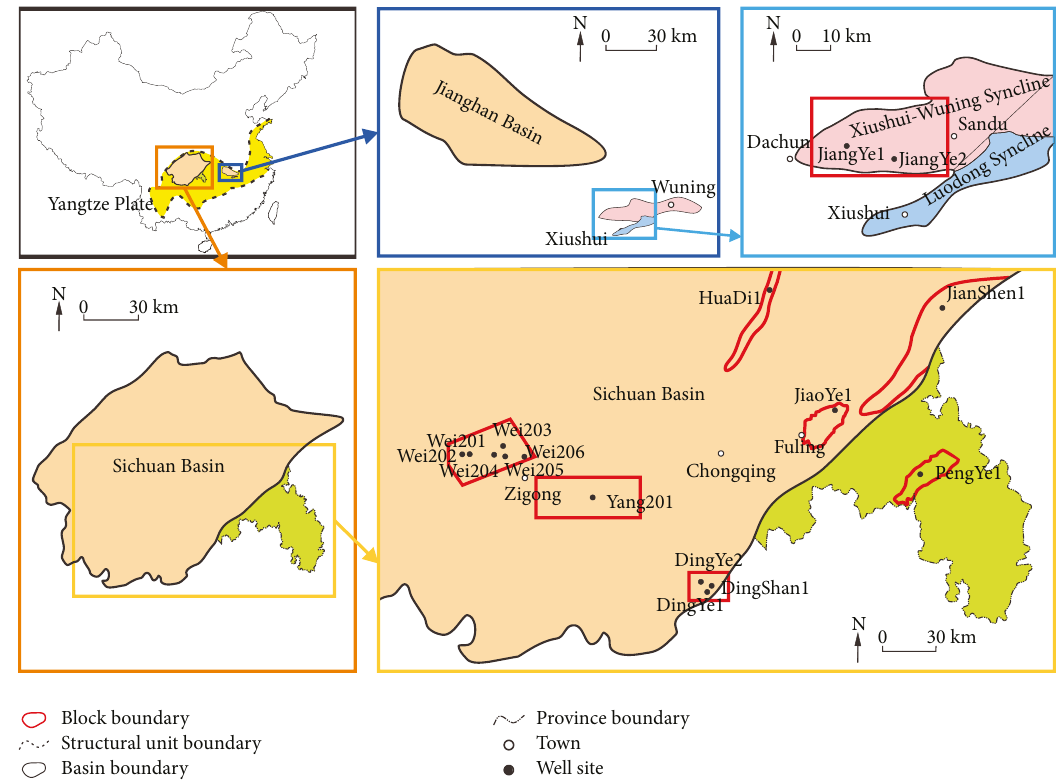
Figure 1: Location maps of the blocks, basins, and wells in this study, which include the Jiaoshiba, Pengshui, Shizhu, Huaying Mountain, Fushun-Yongchuan, and Weiyuan blocks; the Xiuwu basin; and the wells sampled